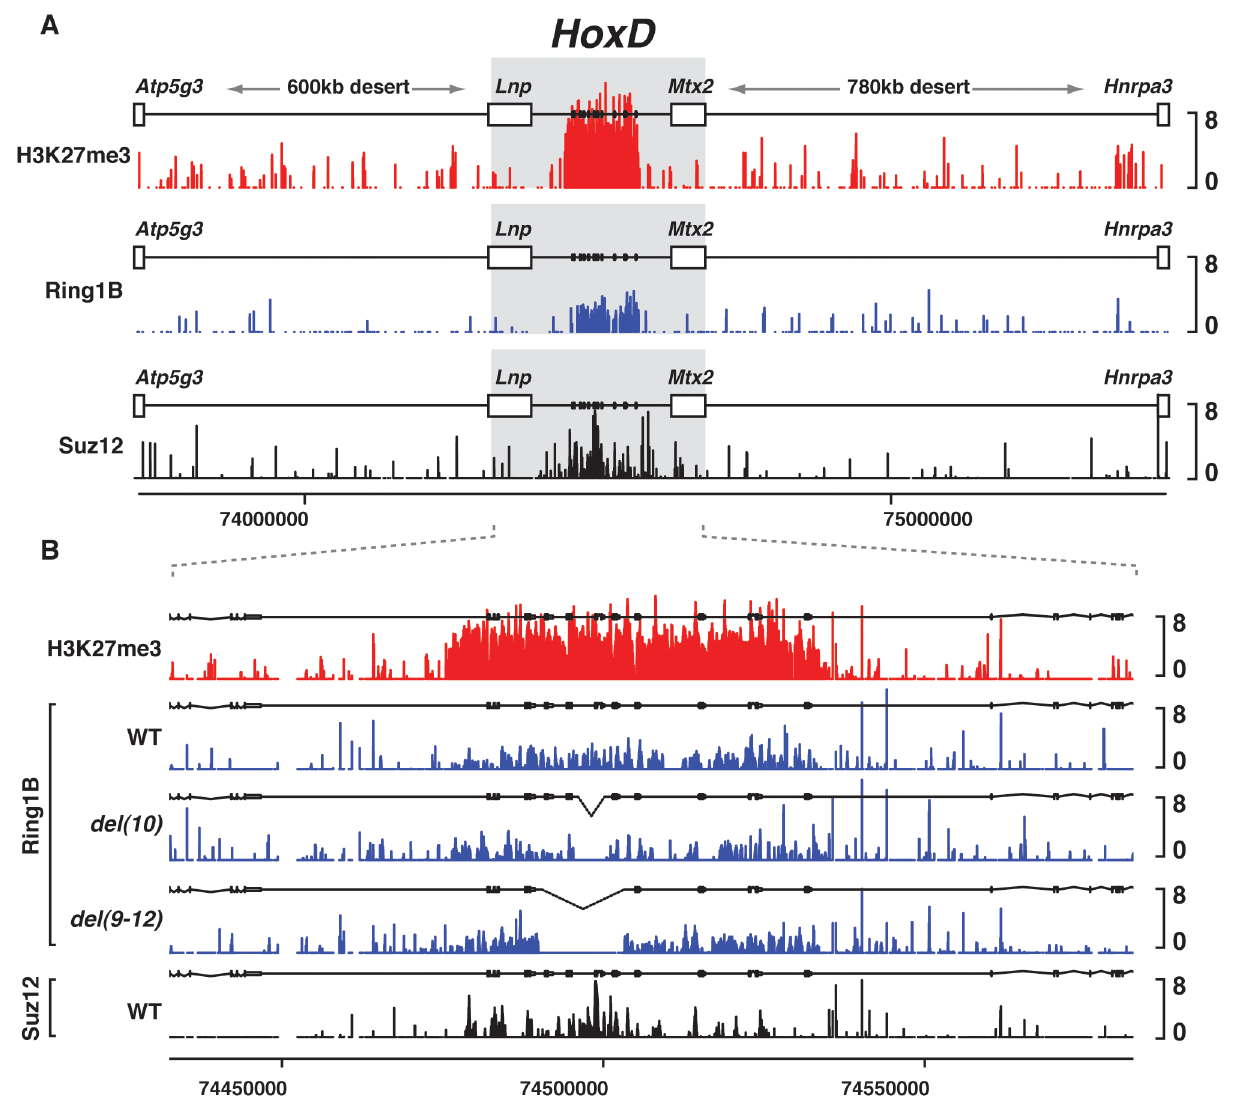
Figure 1. PRC1/2 profiles in various genetic configurations. (A) Wild type genomic landscape of the murine HoxD cluster flanked by two large gene deserts on its centromeric and telomeric sides. Log2 profiles of H3K27me3 (red), PRC1 (blue) and PRC2 (black) enrichment obtained on tiling arrays from embryonic tissues. (B) Effect on PRC1 binding profiles of mutant genetic configurations (blue), compared to wild type PRC2 (black) and H3K27me3 (red). Alleles are specified on the left.